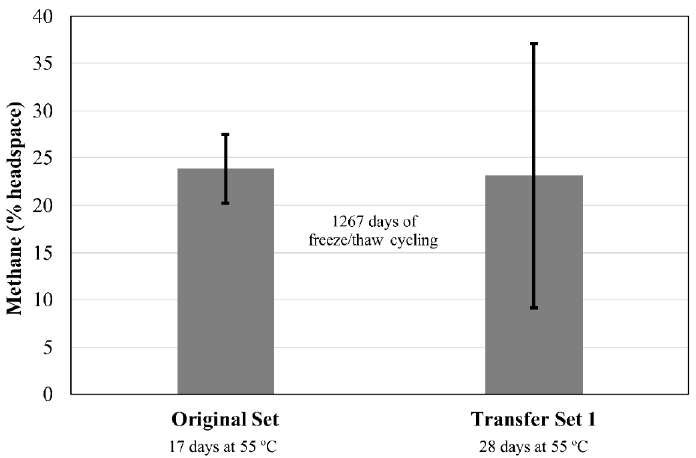
Figure 6. Methane production by Methanothermobacter wolfeii following an initial incubation period for each of two sets. Original Set test tubes contained 5 mL MM medium. Transfer Set 1 test tubes contained 10 mL MM medium. Transfer Set 1 tubes ( n = 5 *) were inoculated from the corresponding replicate in the Original Set ( n = 5) following 1284 days of freeze/thaw cycles (Table 5). Error bars indicate ± one standard deviation. * Two of five replicates within Transfer Set 1 failed to produce methane after 28 days’ incubation and are not included in the data shown here.